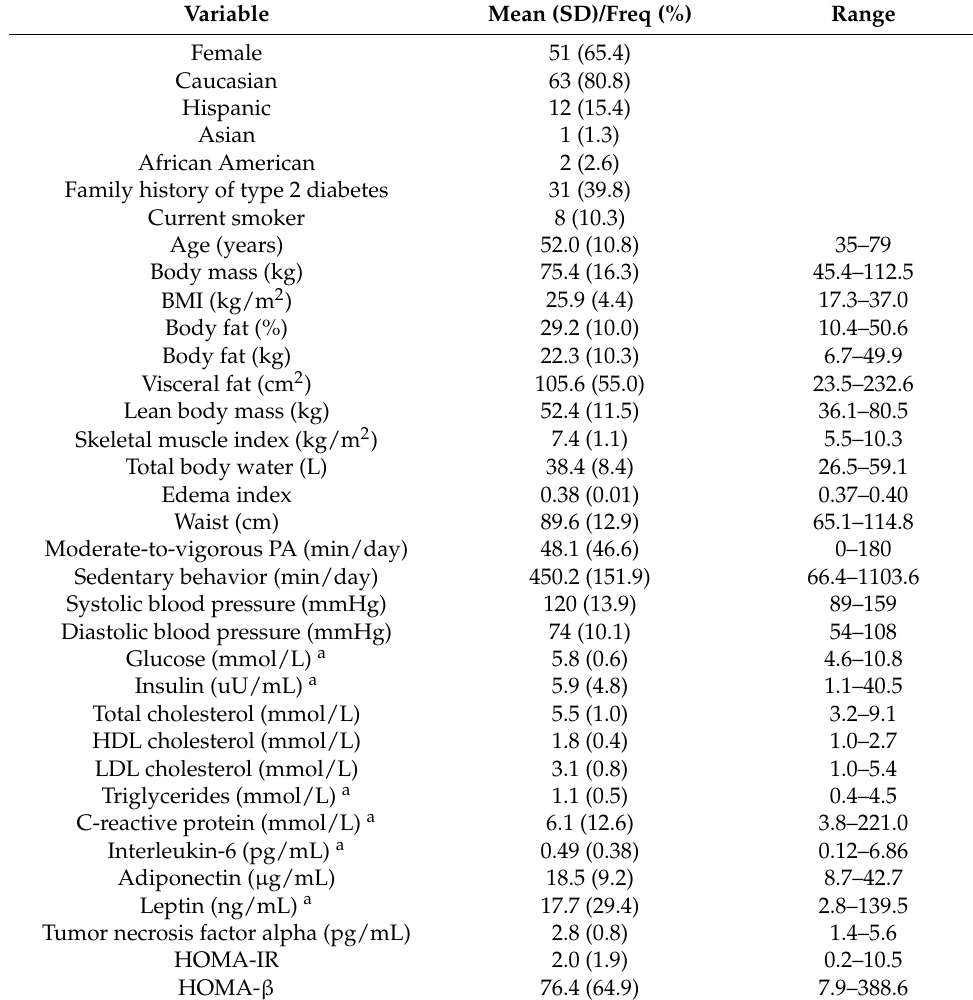
Table 1. Participant Characteristics ( n =